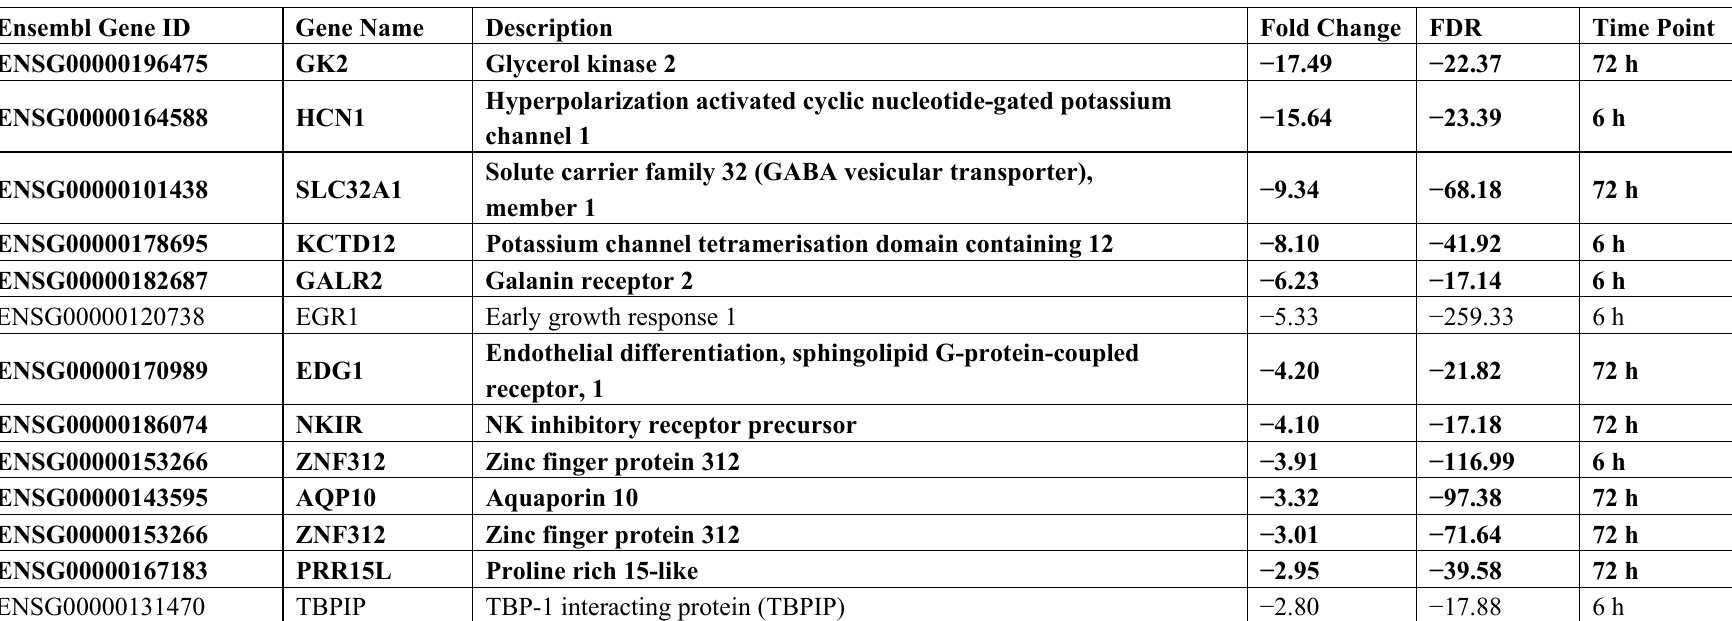
Table 2. The 25 most highly downregulated genes during acute HCV infection. Genes are presented in the order of fold change relative to controls and the time after HCV infection and FDR values are provided. Newly identified downregulated genes are shown in bold. A complete list of significantly upregulated genes are provided in Supplemental